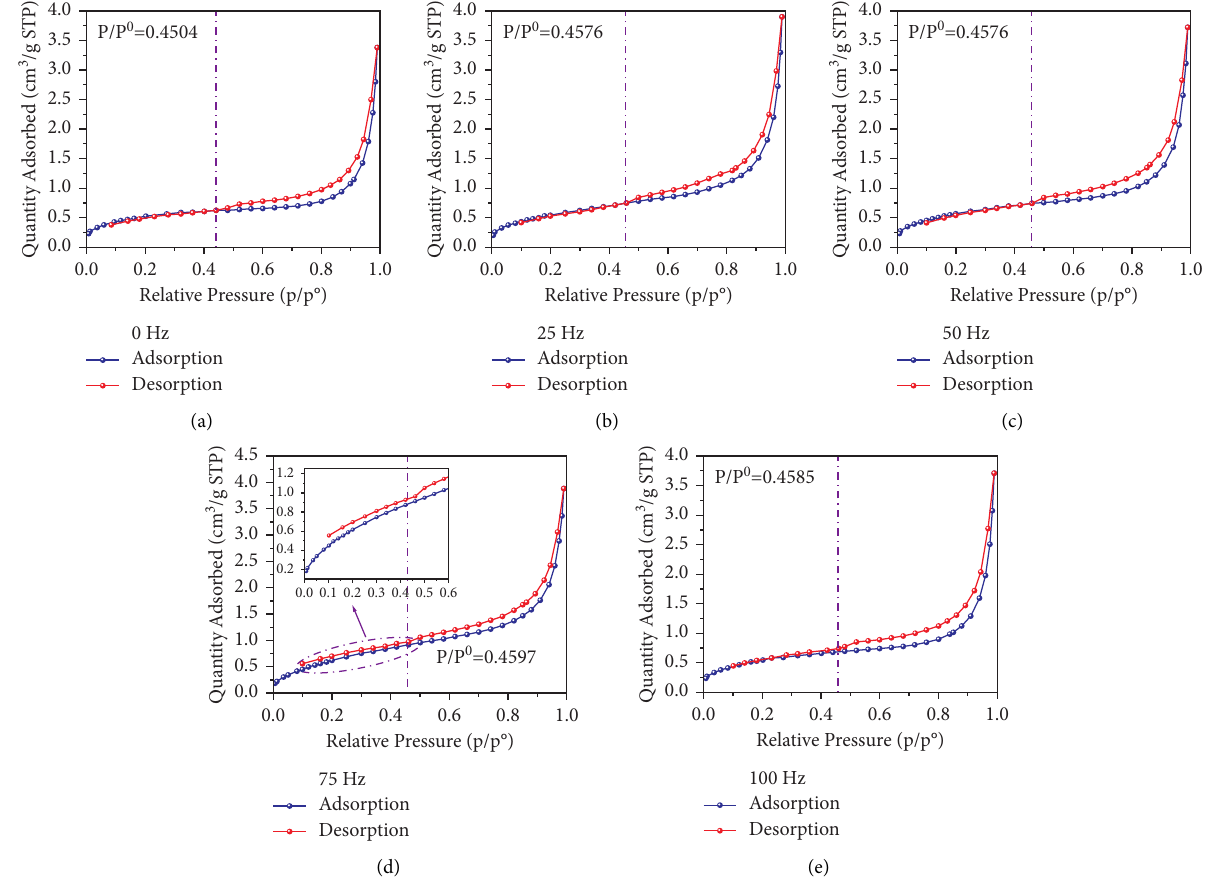
Figure 6: LPNA adsorption and desorption isotherms in the VDF coal samples.